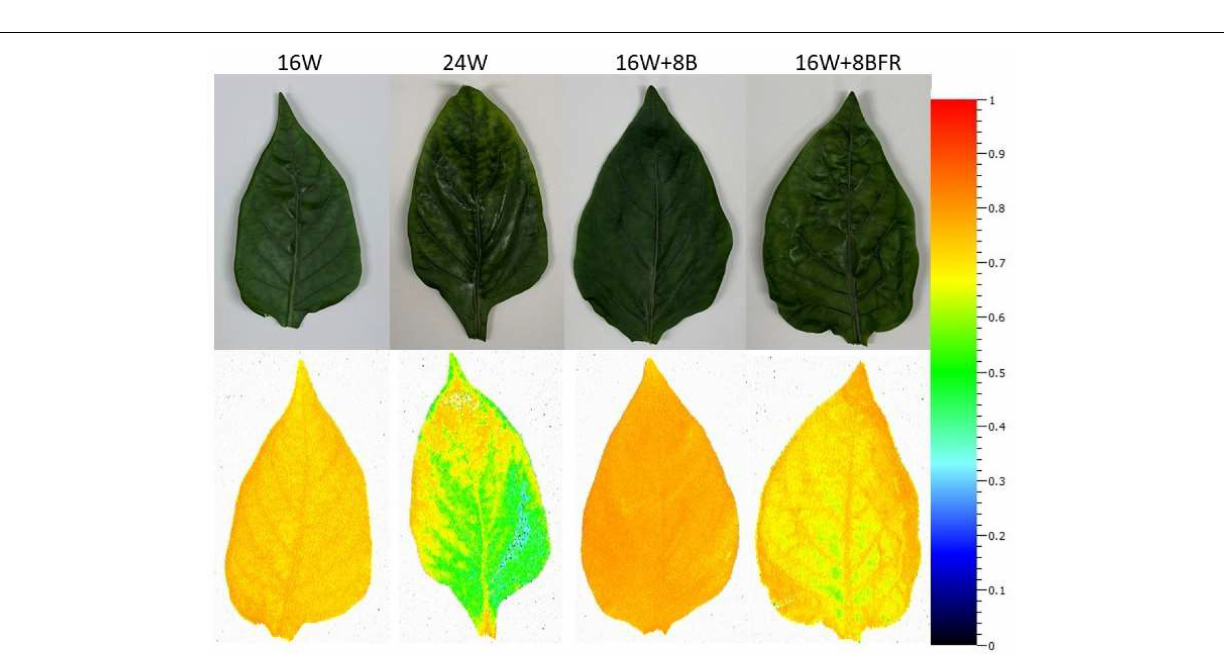
FIGURE 6 | Spatial response of F v /F m from the fifth leaf of peppers grown under all light treatments measured at 110 DIT.